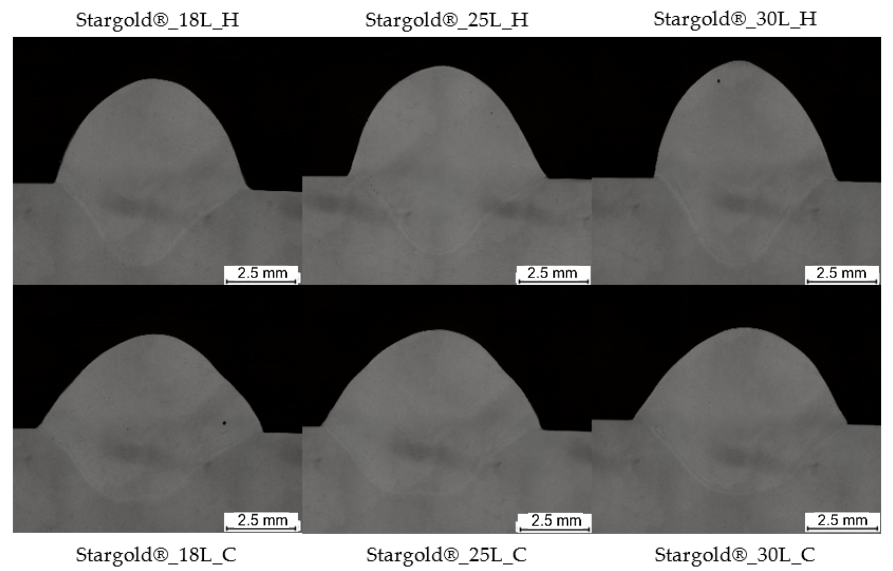
Figure 5. Cross-sections of single weld beads with CMT and Stargold ® shielding gas.